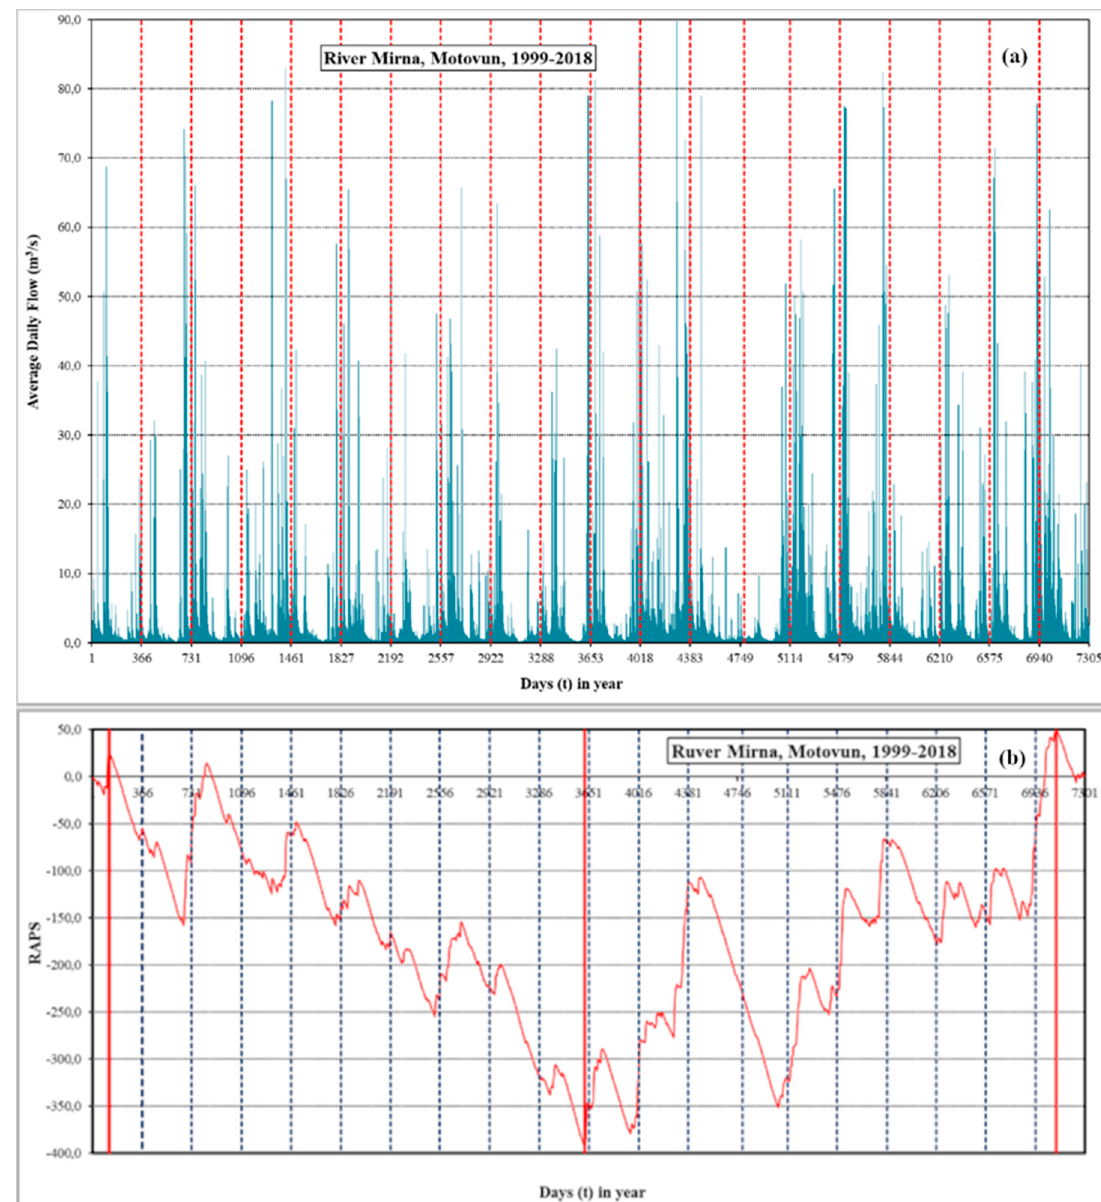
Figure 5. Average daily flows ( a ) and RAPS diagram ( b ) for the Mirna River during the period 1999–2018.